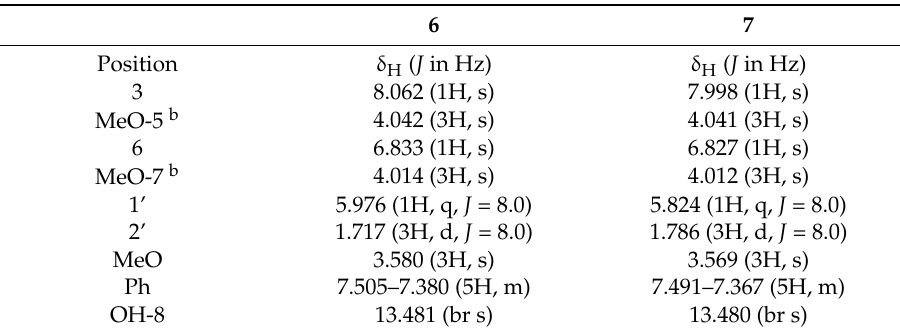
Table 1. 1 H-NMR data of 6 and 7 recoded in CDCl 3 a.